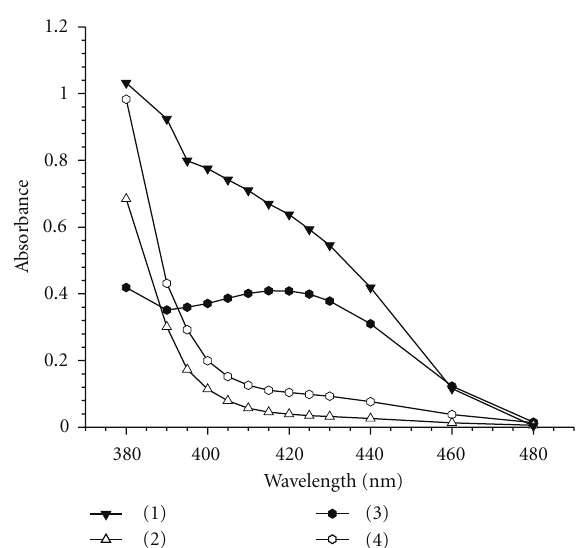
Figure 1: Absorption spectra of (1) sample versus reagent blank (7.5 μ gmL − 1 GBP)-method A; (2) reagent blank-method A; (3) sample versus reagent blank (8.0 μ g mL − 1 GBP)-method B; (4) reagent blank-method B.